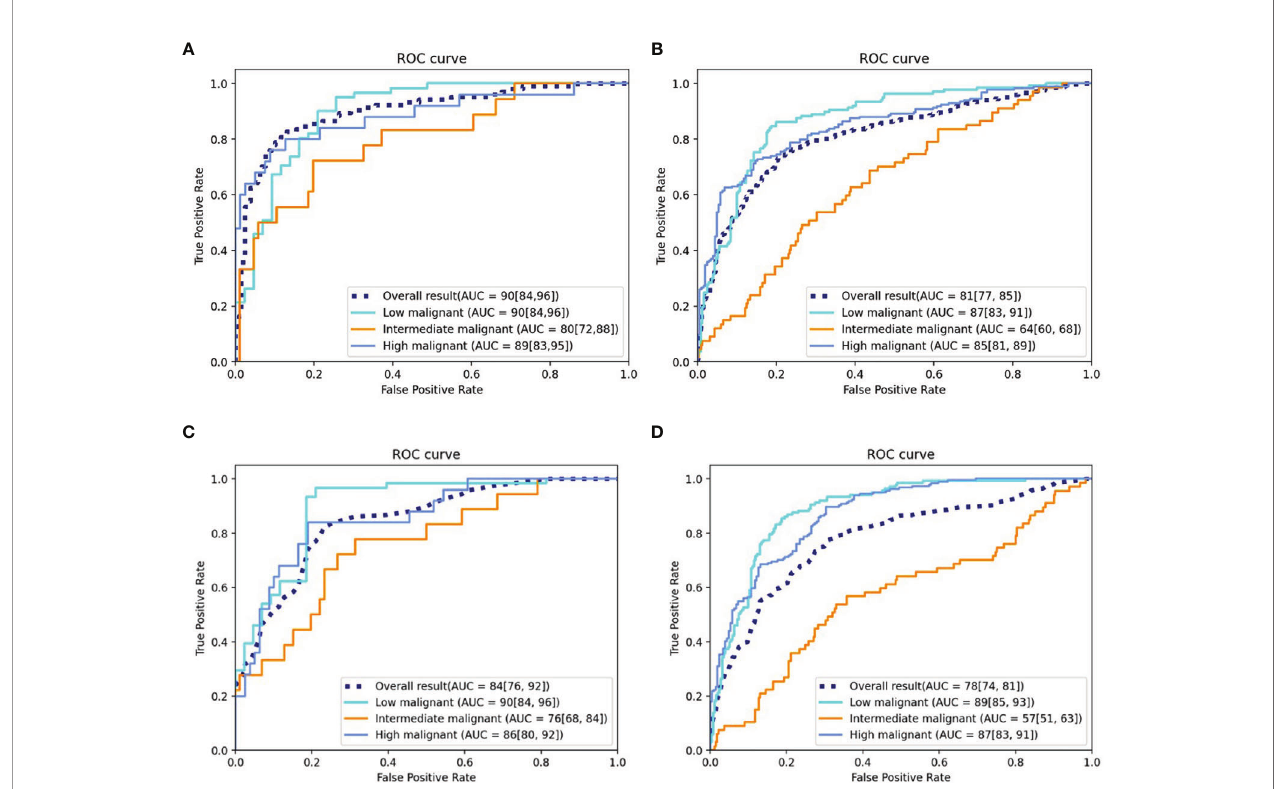
FIGURE 4 | ROC curves of the DLM and radiomics model. (A) ROC curve of the DLM for the testing cohort. (B) ROC curve of the DLM for the independent external validation cohort. (C) ROC curve of the radiomics model for the testing cohort. (D) ROC curve of the radiomics model for the independent external validation cohort. ROC, receiver operating characteristic; AUC, area under the curve; DLM, deep learning model.